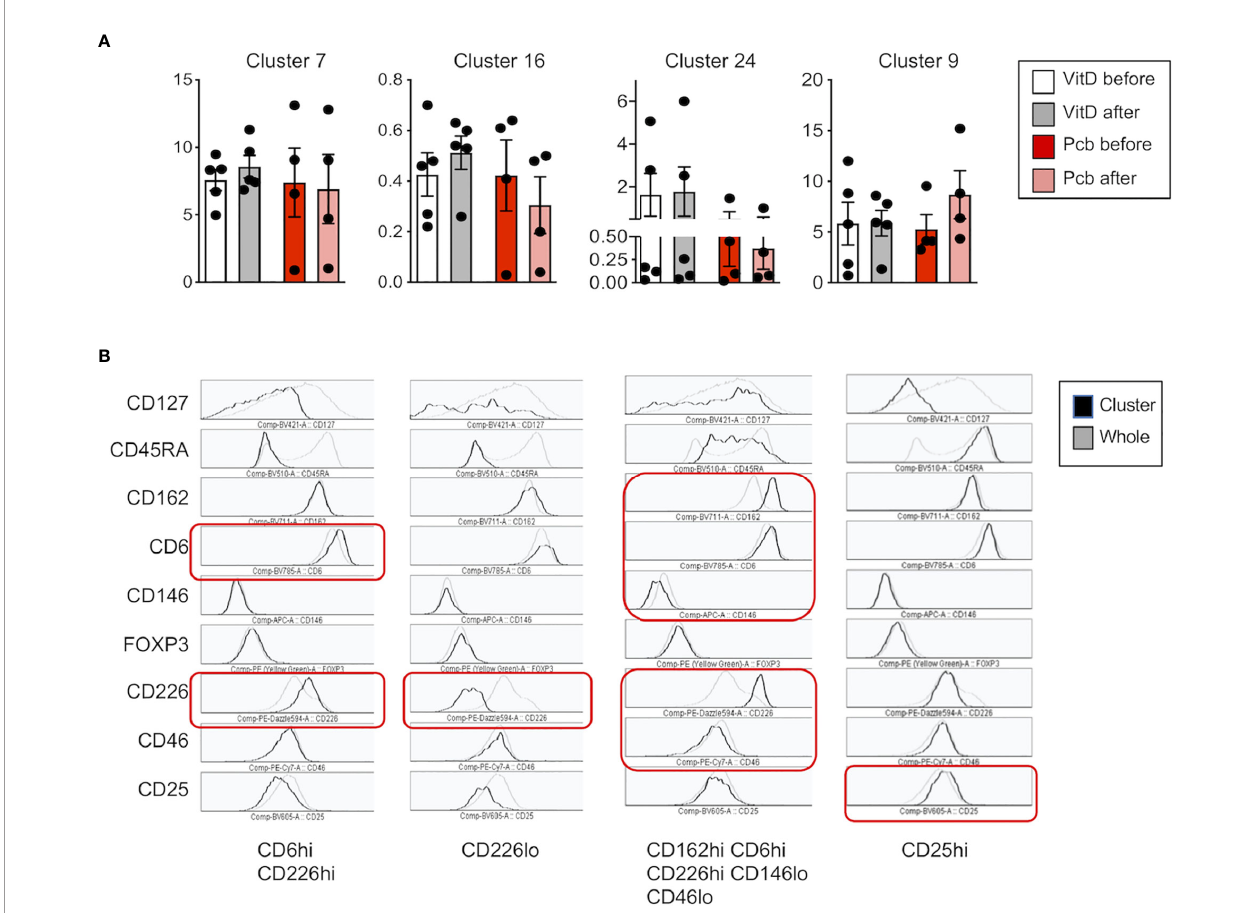
FIGURE 7 | Vitamin D supplementation modulates the expression of adhesion molecules on CD4+ T cells in patients with multiple sclerosis (MS). (A) Percentage and (B) phenotype of the clusters increased after vitamin D supplementation (clusters 7 and 16), decreased by placebo (clusters 16 and 24) or increased by placebo but stable with vitamin D (cluster 9). The phenotype represented is from the Vitamin D after group and is representative of the four different groups as they represent the phenotype of the cells clustered